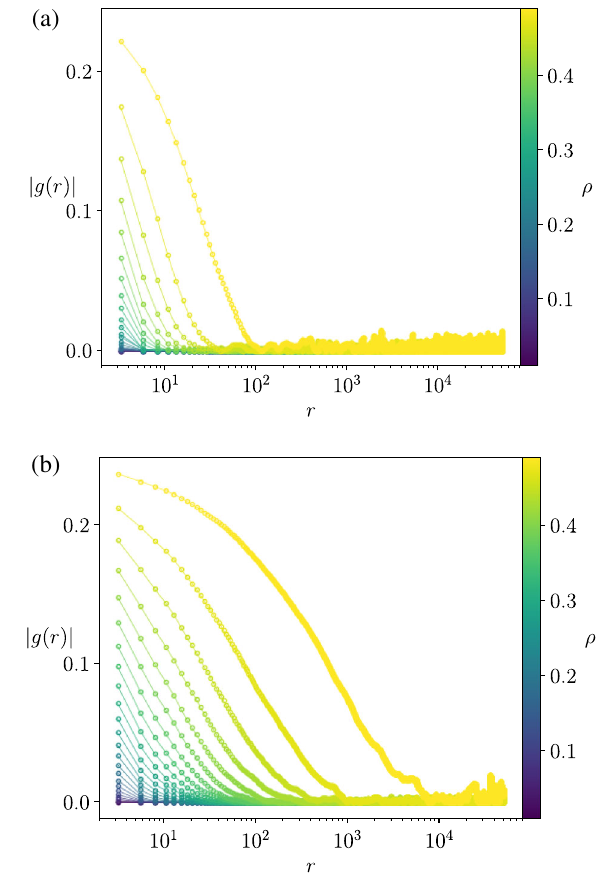
FIG. 2. Absolute value of the autocorrelation function g ð r Þ ≡ i − h x i 2 for the 1D conserved lattice gas model for h x i x i þ r (a) uniformly sampled absorbing states and (b) absorbing states arrived at by the dynamics. The 1D CLG dynamical states are correlated over a much larger